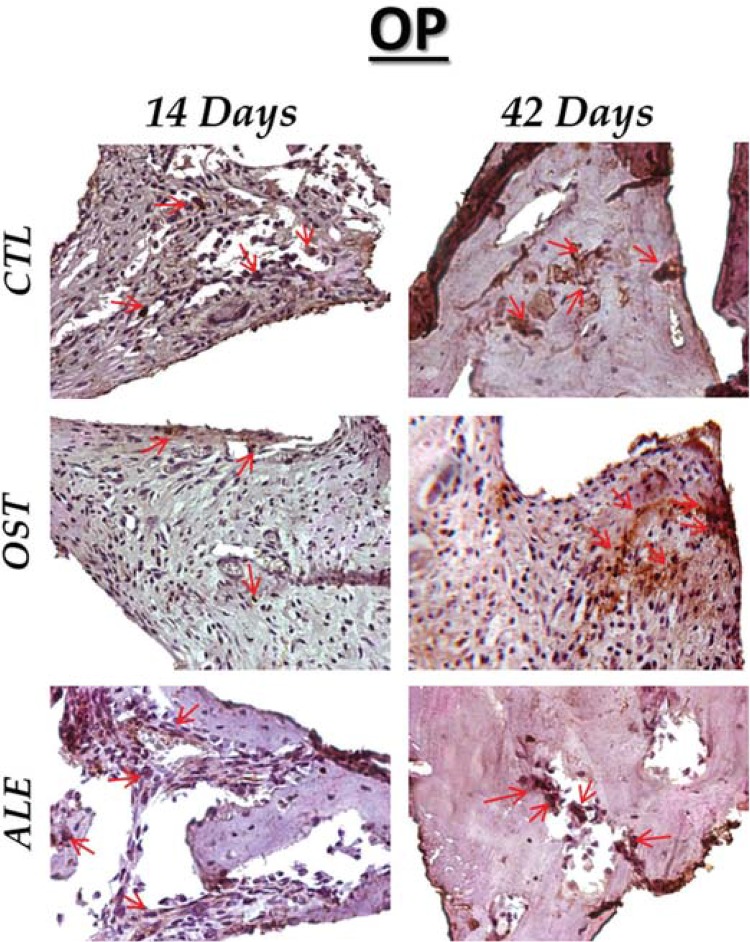
OP immunostaining at 14 days for the experimental groups (CTL: moderate; OST: moderate; ALE: moderate). At 42 days (CTL: moderate; OST: moderate; ALE: light). Immunolabeling indicated by red arrows. (Original, 40x)